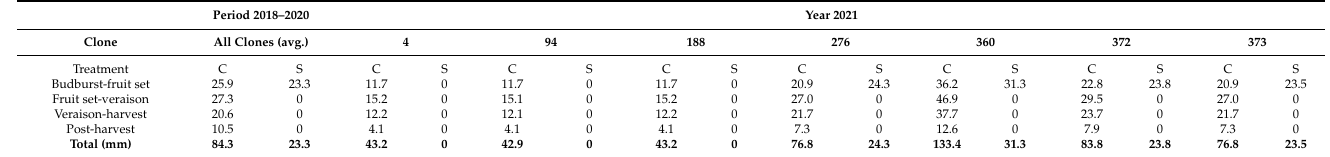
Table 2. Water volume applied for each treatment (control and stress) in each phenological period and total for every year of the experiment (2018–2021). Treatments: C: control; S: